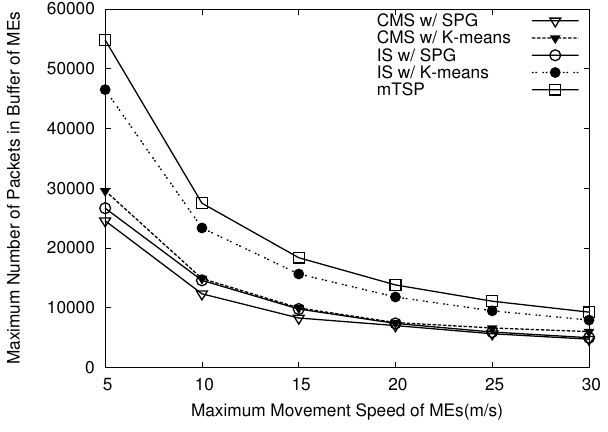
Figure 14. Effects of movement speed on maximum number of packets in buffer of